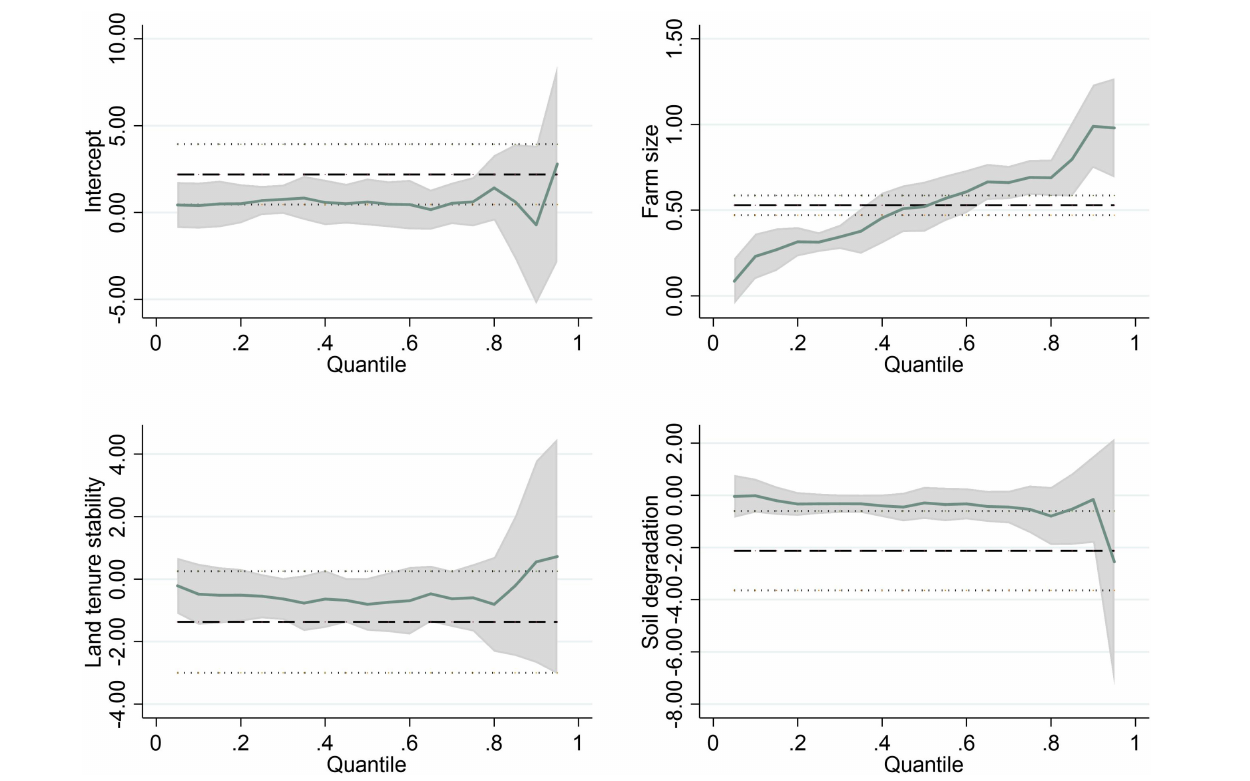
FIGURE 2 | Quantile estimates: The impacts of factors on banana income. Shaded areas represent 95% confidence band for the quantile regression estimates. The black dotted lines denote the conventional 95% confidence intervals for the